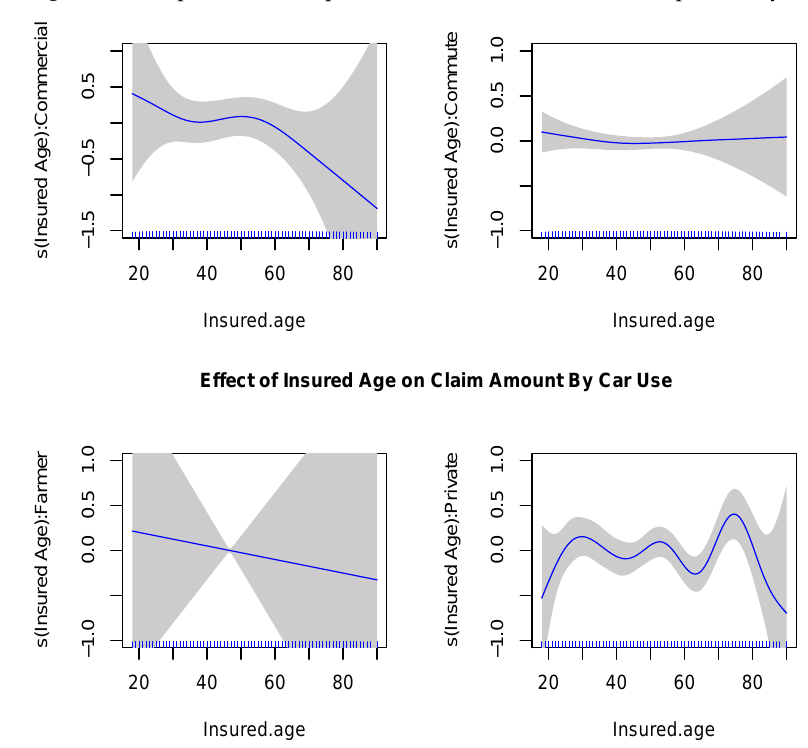
Figure 13. The plots of fitted spline functions for Credit Scores, separated by Car Use.